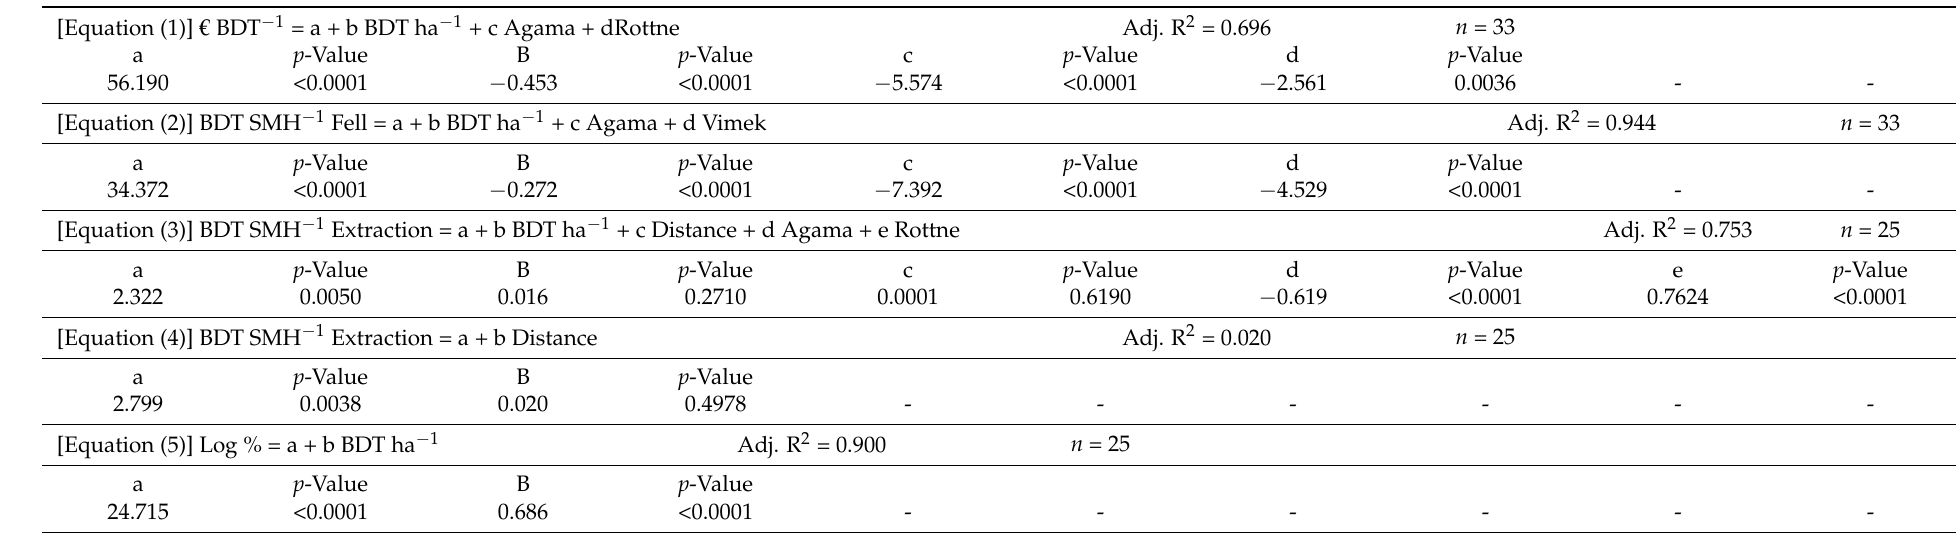
Table 4. Results of the regression